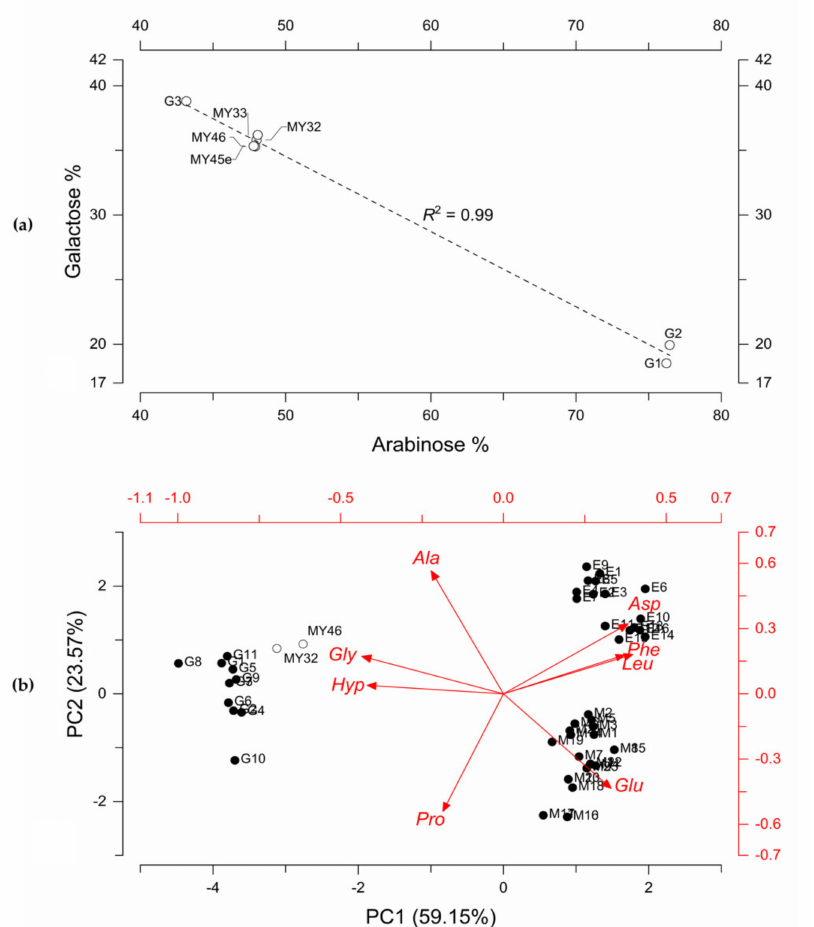
Figure 6. ( a ) Arabinose vs galactose bivariate plot; ( b ) PCA biplot on the various possible proteina- ceous binding mediums references and the samples MY46 and MY32. G1: C; G2: CYO; G3: CRO; G4: CVB; G5: CSJW; G6: CGE; G7: CSM; G8: AzCpi; G9: AzCpv; G10: Cpv10; G11: GI; M1: L; M2: LYO; M3: LRO; M4: LVB; M5: LSJW; M6: LGE; M7: LSM; M8: AzLtv; M9: Ltv (uv); M10: BpLti10P; M11: TvLtv; M12: TvLtv©; M13: BpLtv(uv); M14: AzLti; M15: AzLtv; M16: BpLti10P; M17: TvLtv; M18: Ltvi23; M19: BpLti©; M20: BpLtv(uv); M21: BpLtv©; M22: TvLtv©; M23: Ltv(uv); E1: U; E2: UYO; E3: URO; E4: UVB; E5USJW; E6: UGE; E7: USM; E8: SmUivi; E9: TvUivg; E10: AzUig; E11: AzUivi; E12: MnTgi; E13: MnTgv; E14: BpUig; E15: BpUivi; E16: Uivg. Azadirachta indica , commonly known as Neem tree ( Tama in Burmese), is a tropical evergreen tree of the Meliaceae Family native to India, and it also grows in Asia, Africa and in central and South America. The Neem oil is isolated from its fruits and seeds; the juice from the sap and finally from the bark gum is obtained as the result of a certain metabolic mechanism of plants and trees [4]. All products derived from the tree contain pesticide components, whereas azadirachtin is best known for its antifungal properties. Most likely, this gum is used as a paint binder, as well as for its pesticide properties, determined by different compounds content in all parts of the tree including the most important azadirachtin [4]. A more recent study reports a high content of arsenic found in three different kinds of Azadirachta indica, whether from Sudan [44]. The walls of the Me-taw-ya temple, made with lime and mud plaster, were attacked by termites and ants [4,6,45] which may have been turned away by neem pesticide components, whereas honey was probably added as a humectant and